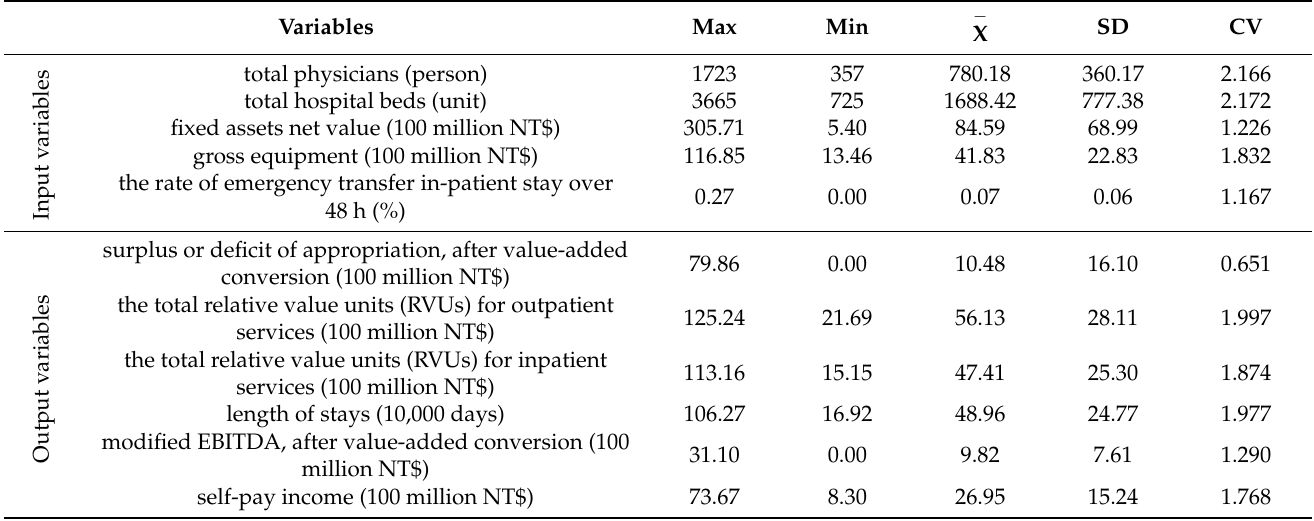
Table 3. Descriptive statistics results of input and output